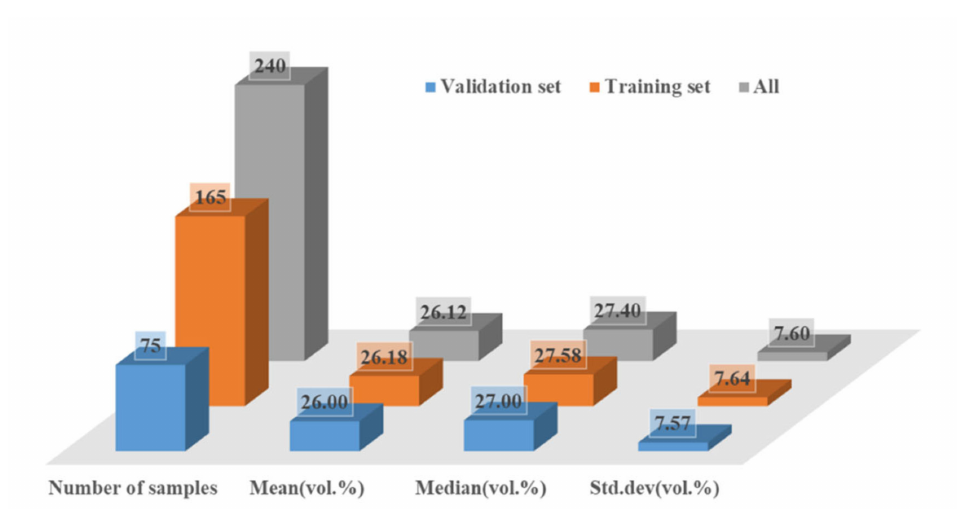
Figure 3. Partial statistical characteristics across the training and validation